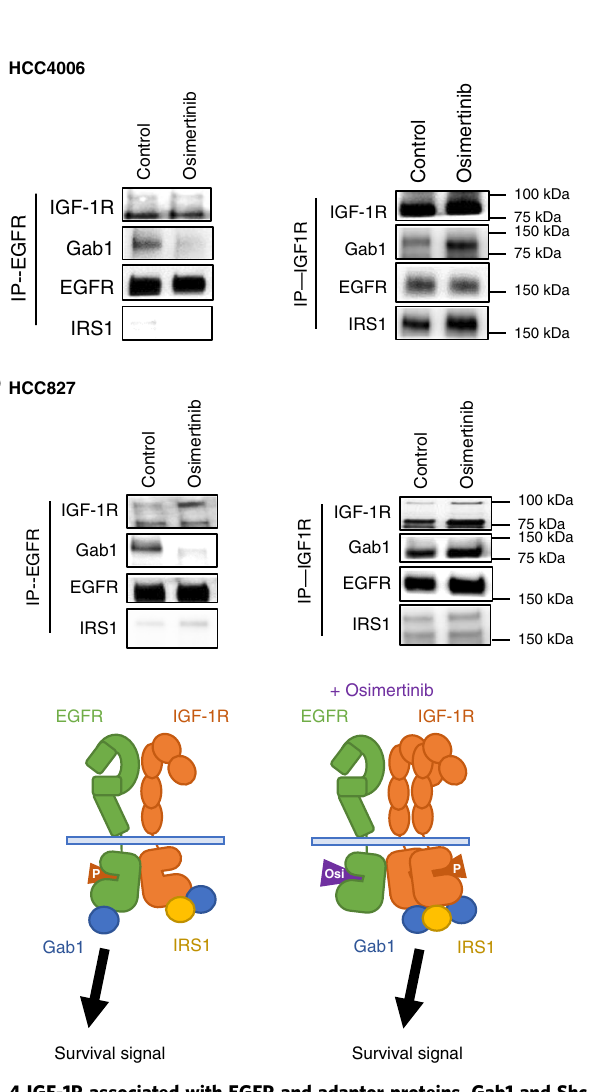
Fig. 4 IGF-1R associated with EGFR and adaptor proteins, Gab1 and Shc. HCC4006 ( a ) and HCC827 ( b ) cells treated with osimertinib (30 nmol/L and 300 nmol/L, respectively) for 72 h were lysed, and the indicated proteins were detected by western blotting, with immunoprecipitation of the indicated proteins. c Schema presenting the mechanism by which AXL- low- expressing EGFR -mutated NSCLC cells adapt to osimertinib exposure. Data shown are representative of three independent experiments. IP